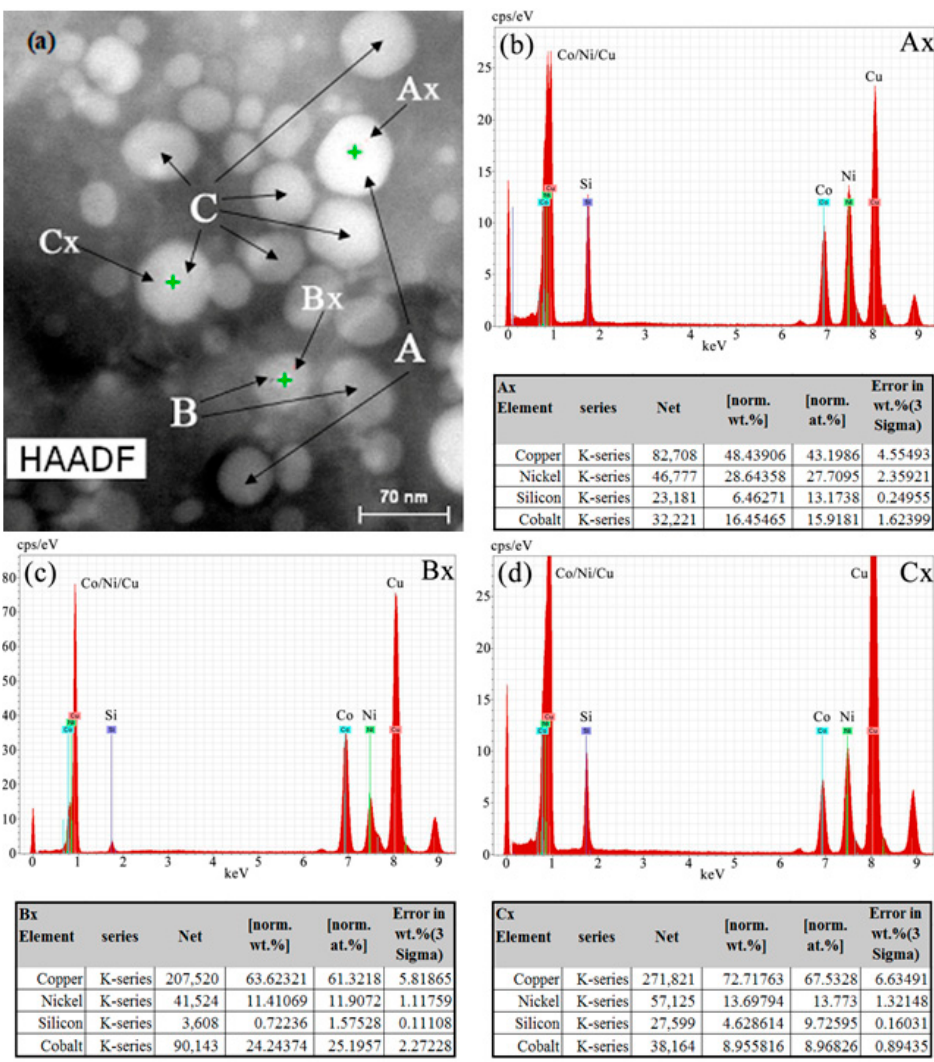
Figure 10. Component analysis of the second phase for the HADDF Z-contrast image of Figure 7b: ( a ) morphology of second phase, ( b ) energy spectrum of Ax, ( c ) energy spectrum of Bx, ( d ) energy spectrum of Cx.